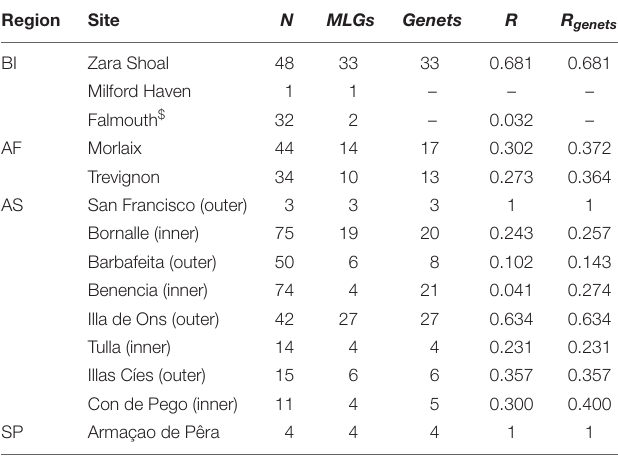
TABLE 1 | Measures of clonal identity of Phymatolithon calcareum along the European Atlantic coast. Region Site N